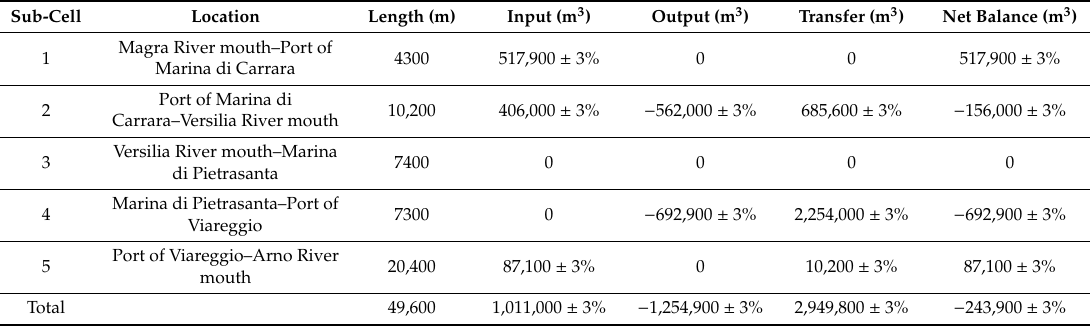
Table 8. Subdivision of the main littoral cell and extent of sediment input, output and transfer. See Figure 1b for the location of sub-cell